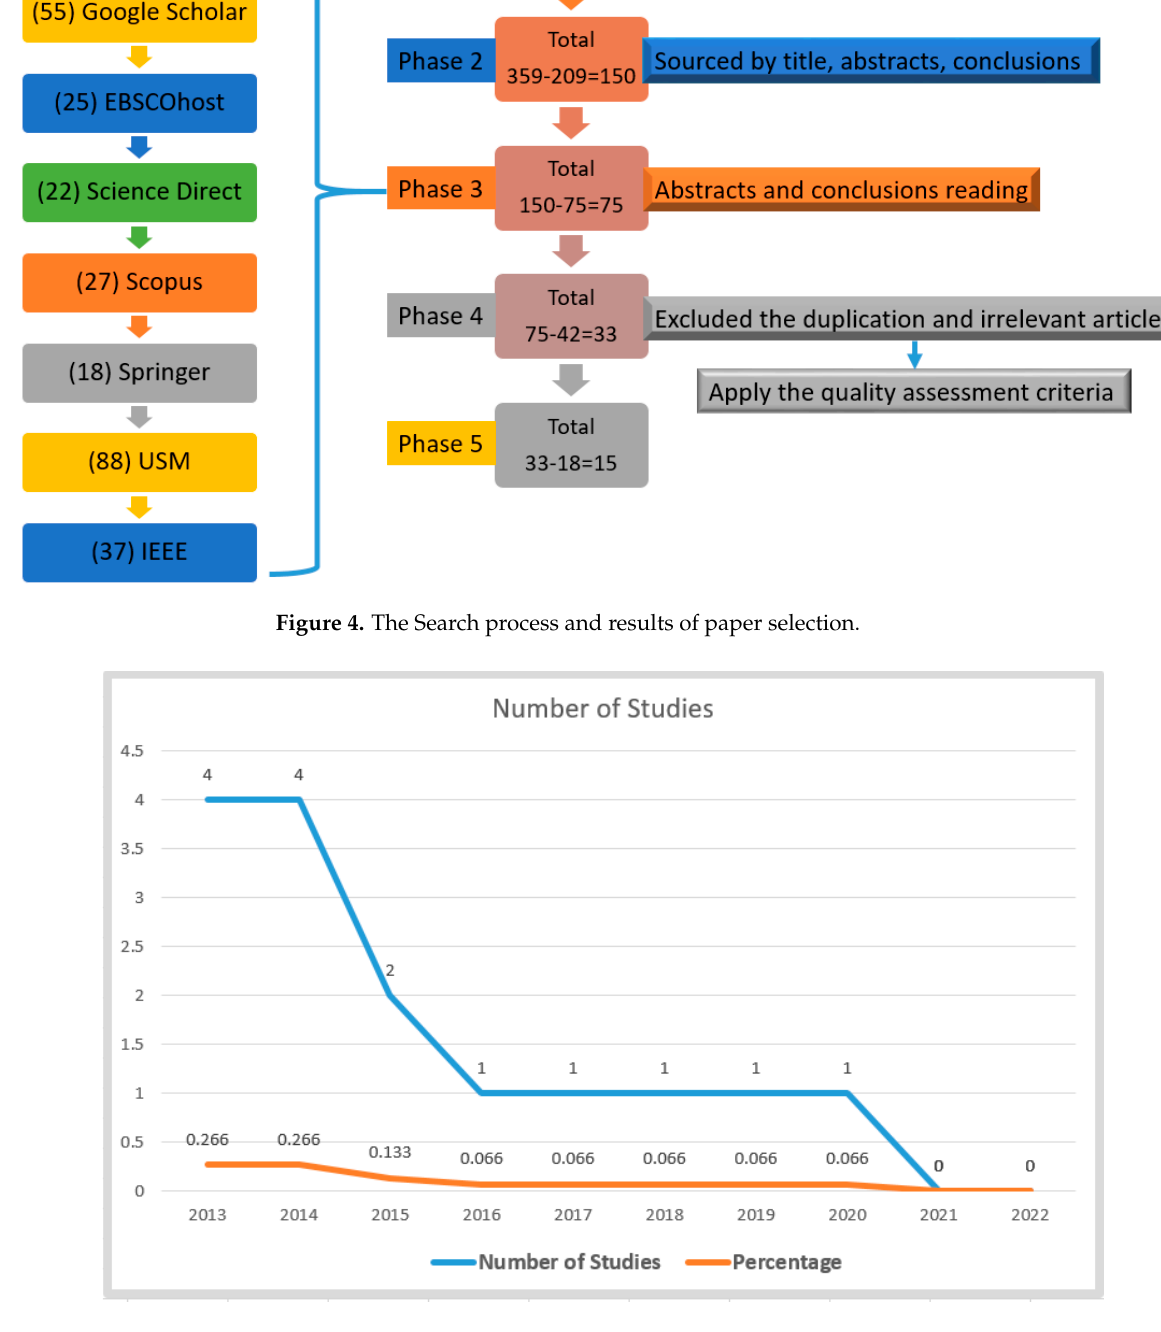
Table 3. Percentage of total studies published, by year.